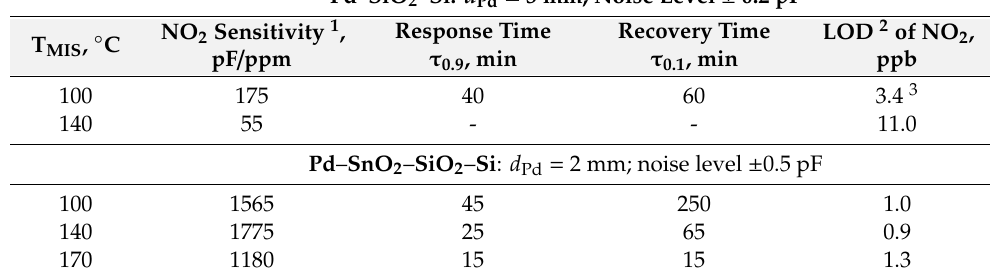
Table 1. The comparative characteristics of the capacitive MIS sensors with structures Pd–SiO 2 –Si and Pd–SnO 2 –SiO 2